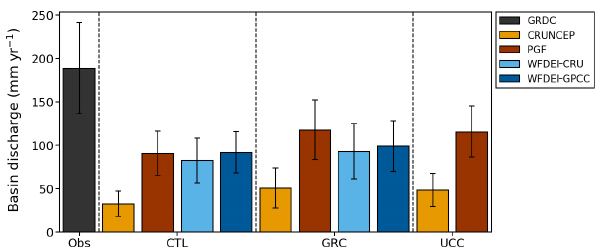
Figure 5. Mean annual observed and modelled basin discharge (mmyr − 1 ) for the common overlap period, 2002–2010.